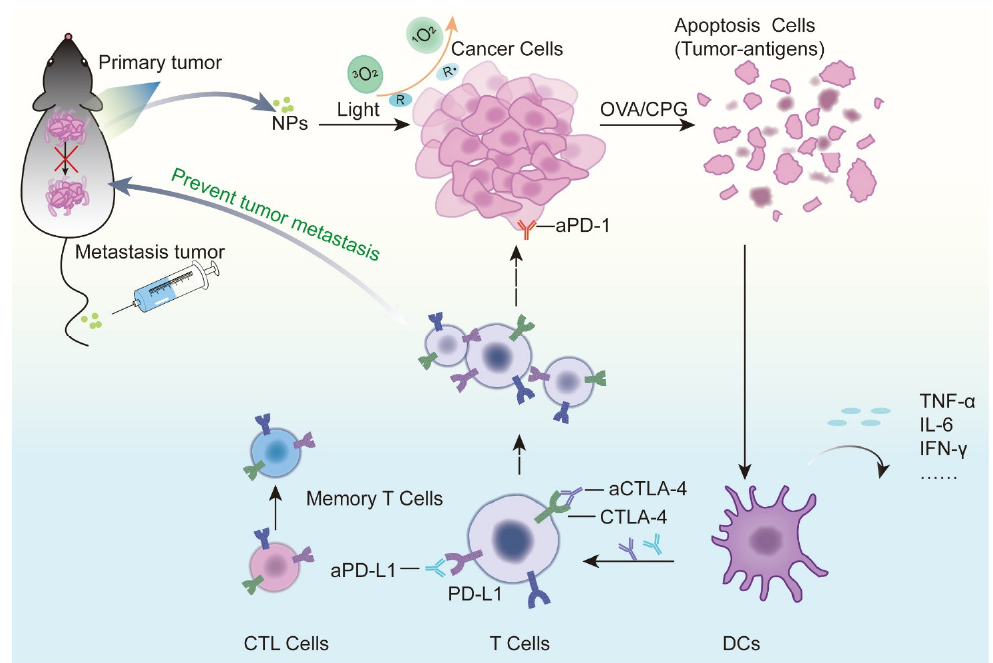
Figure 3. Mechanism by which photodynamic therapy and immunotherapy synergistically enhance antitumor effects. When photosensitizers in tumor sites are activated, they can cause acute inflammation and induce cell apoptosis or necrosis. Dendritic cells mature when stimulated by cytokines released at the site of inflammation and provide antigens to T lymphocytes in regional lymph nodes. Activated T lymphocytes become effector T cells, which are attracted to chemokines, migrate to the tumor and kill tumor cells. Different types of immunotherapy drugs play a role in different steps of the complete antitumor immune cycle. Codelivery of a photosensitizer with an immune adjuvant or tumor antigen can synergistically enhance the activation of the host immune system and improve the immunosuppressive microenvironment. The codelivery of a photosensitizer with CTLA-4 and PD-L1 monoclonal antibodies can enhance the antitumor immunity effect of T cells. The activation of these immune cells also plays a role in preventing metastasis and recurrence.